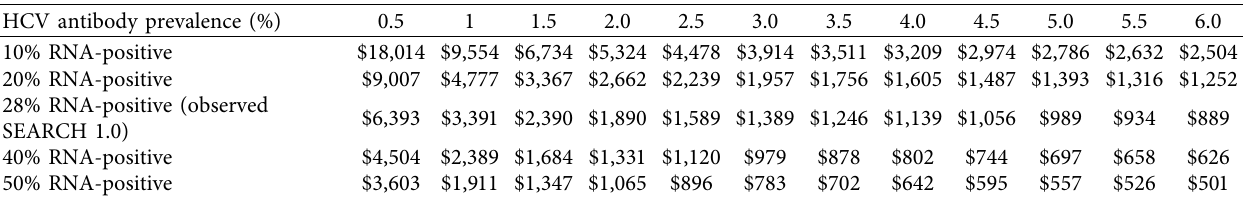
∗ Does not include costs of work-up for RNA-positive patients for direct-acting antiviral treatment. AUD, Australian dollars; RNA, ribonucleic acid; HCV, hepatitis C